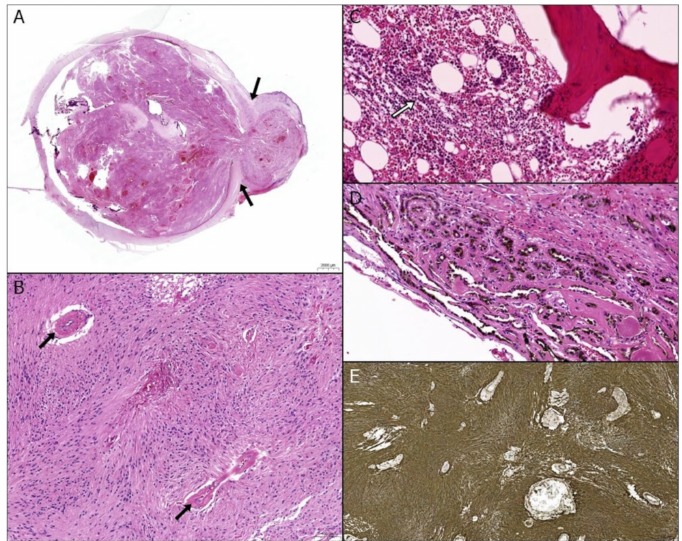
Figure 2. Microscopic findings. ( A ) Whole mount view of the left eye displayed a mass lesion filling the entire vitreous cavity and protruding into the anterior chamber (arrows) (H & E stain, × 44). ( B ) The mass lesion consisted of interweaving spindle cells forming fascicular and whirling patterns. Cytologic atypia was absent and mitotic activity was scanty (<1/50 HPF). Vessels with thick hyalinized walls (arrows) were scattered throughout the lesion. Note the predominance of spindle cells over vascular proliferation (H & E stain, × 100). ( C ) Metaplastic bone formation was present with intramedullary hematopoiesis (white arrow) (H & E stain, × 100). ( D ) Focal reactive hyperplasia of the retinal pigment epithelium was present at the base of the mass (H & E stain, × 200). ( E ) Diffuse intense positivity for GFAP immunohistochemical staining confirmed the exuberant proliferation of glial cells ( × 50). Pathologic diagnosis was massive retinal gliosis (MRG) with a Ki-67 labeling index of 10%. MRG is a rare benign intraocular lesion resulting from non-neoplastic glial cell proliferation [1]. Clinically, the mass forming feature of MRG can be easily mistaken for a malignant tumor, such as retinoblastoma, uveal melanoma, or intraocular metastatic tumor. The diagnosis can be made only after a histopathologic examination. The intense positivity of GFAP identified the proliferative spindle cells as glial cells, and eliminated the possibility of retinoblastoma or melanoma. Once the proliferating cells are confirmed as glial cells, the differential diagnosis can be narrowed down to retinal glial tumors and pseudotumors, such as retinal hemangioma, vasoproliferative tumors of the retina (VPTR), and MRG. In the previous literature, Housten et al. and Irvine et al. suggested that retinal hemangioma, VPTR, and MRG belonged to a spectrum of the same disease process; retinal hemangioma at one end of the spectrum with vascular-predominance, MRG at the other end with glial predominance, and VPRT between the two ends with both vascular and glial components represented [2,3]. In this case, hyalinized blood vessels were scattered throughout the lesion. However, the exuberant glial proliferation was much more predominant. Three histopathologic criteria for MRG diagnosis have been described by Yanoff et al.: focal or total retinal replacement by the proliferating glial tissue, atypical blood vessels within the tumor, and obliteration of the normal retinal architecture by the proliferating glial tissue [1]. All features were clearly displayed in the present case. MRG is considered as a longstanding tissue response process following retinal injury, such as chronic inflammation, trauma, glaucoma, vascular disorders, and congenital anomalies [1,2,4,5]. The clinical setting of the present case with phthisis bulbi due to trauma was also compatible with MRG. Although MRG is a rare non-neoplastic lesion, it should always be considered as a differential diagnosis when encountering an intraocular mass. Being aware of the possibility can facilitate making the correct diagnosis, as it can be mistaken for a malignant